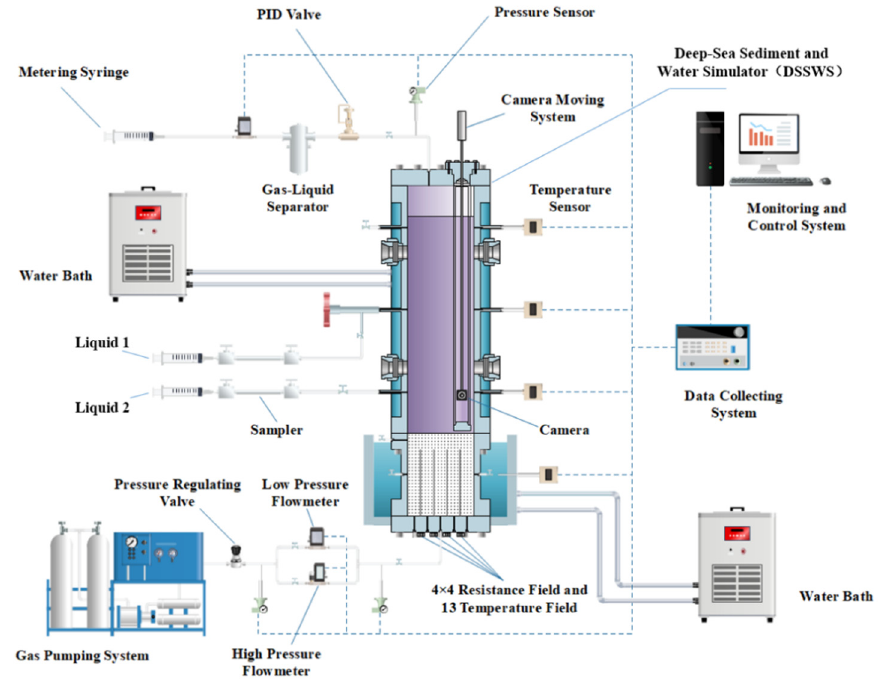
Figure 9. Schematic diagram of the experimental system.